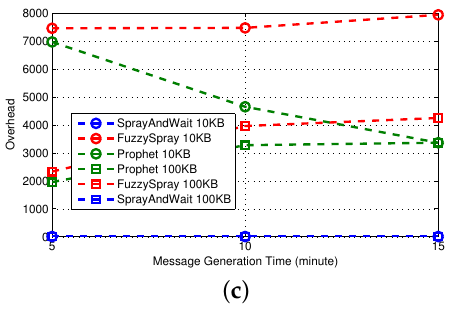
Figure 9. Performance of single technique protocols in a real-world outdoor setting.